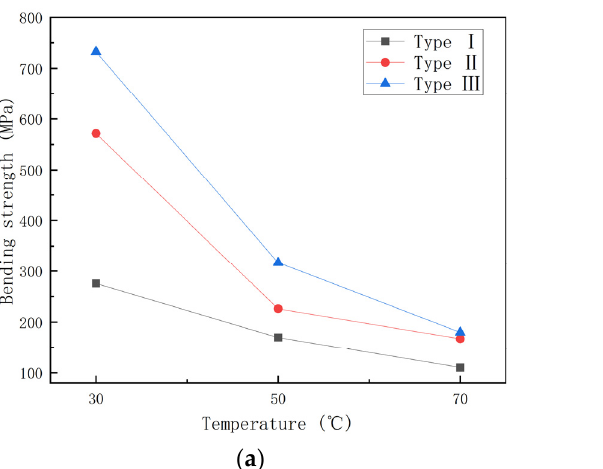
Figure 7. Bending strength curve of GFRP pipes. ( a ) Bending strength-temperature curve; ( b ) Bending strength–sample type curve.